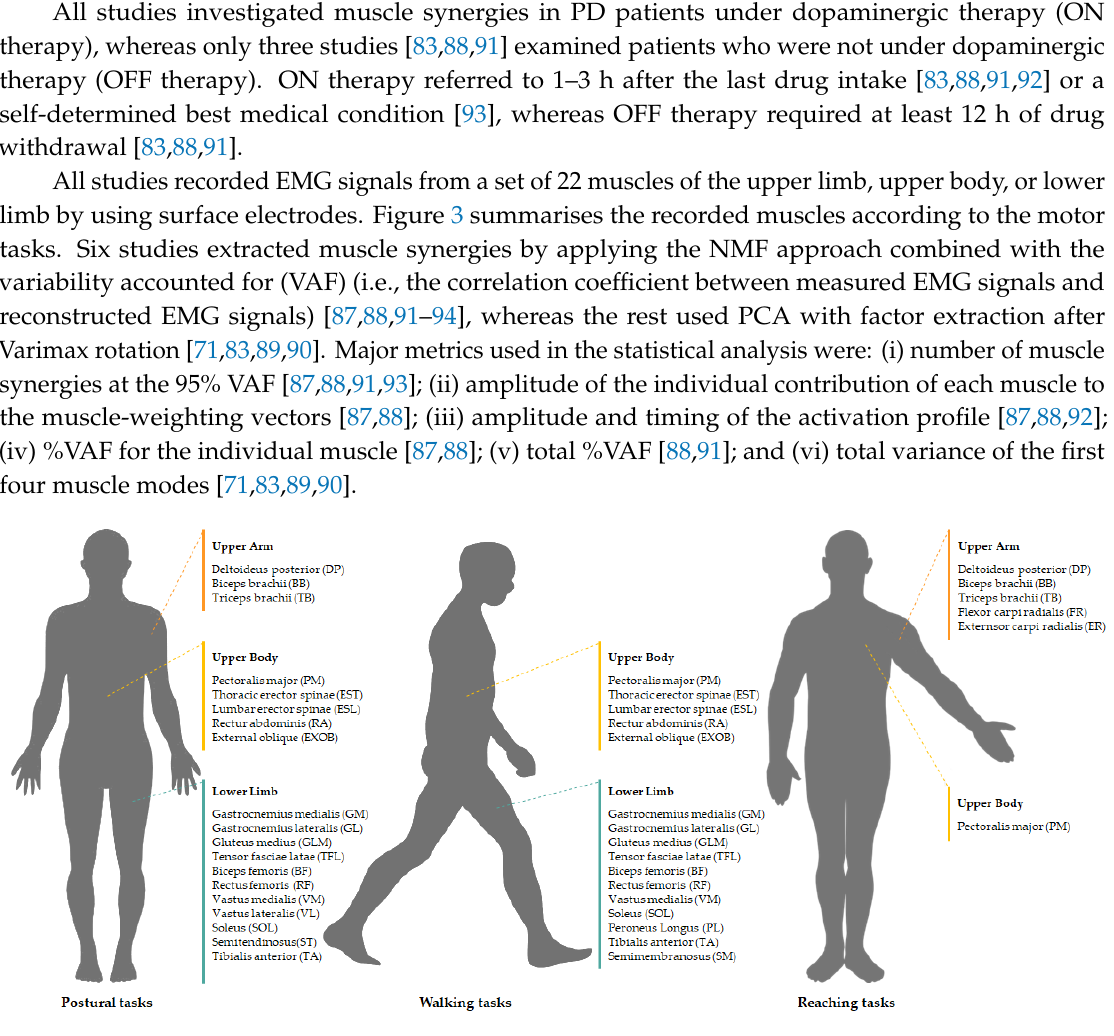
Figure 3. Muscles recorded by surface EMG to analyse muscle synergies in Parkinson’s disease patients during postural, walking and reaching tasks.